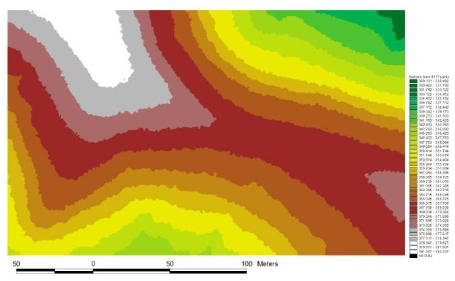
Figure 3. DEM generated from the original LiDAR data of 0.2705pts/m 2 point cloud density.